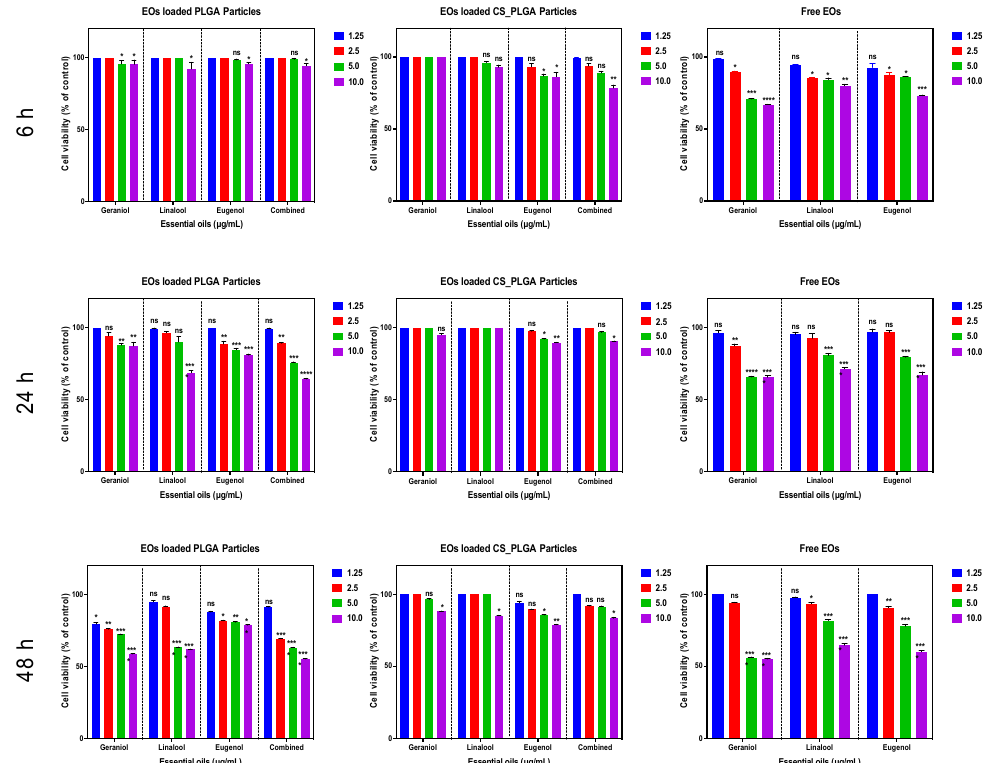
Figure 10. Cytotoxic effect of free and encapsulated EO components (within uncoated and CS-PLGA particles) on FKD-1-R cells measured by MTT assay. Results are expressed as the means of cell viability (% of control) ± standard errors. The level of difference was measured by one-way ANOVA followed by Dunnett’s multiple comparisons. Asterisks denote statistical significance (* p < 0.05; ** p < 0.01; *** p <0.001; **** p < 0.0001 compared to control groups and ns denotes